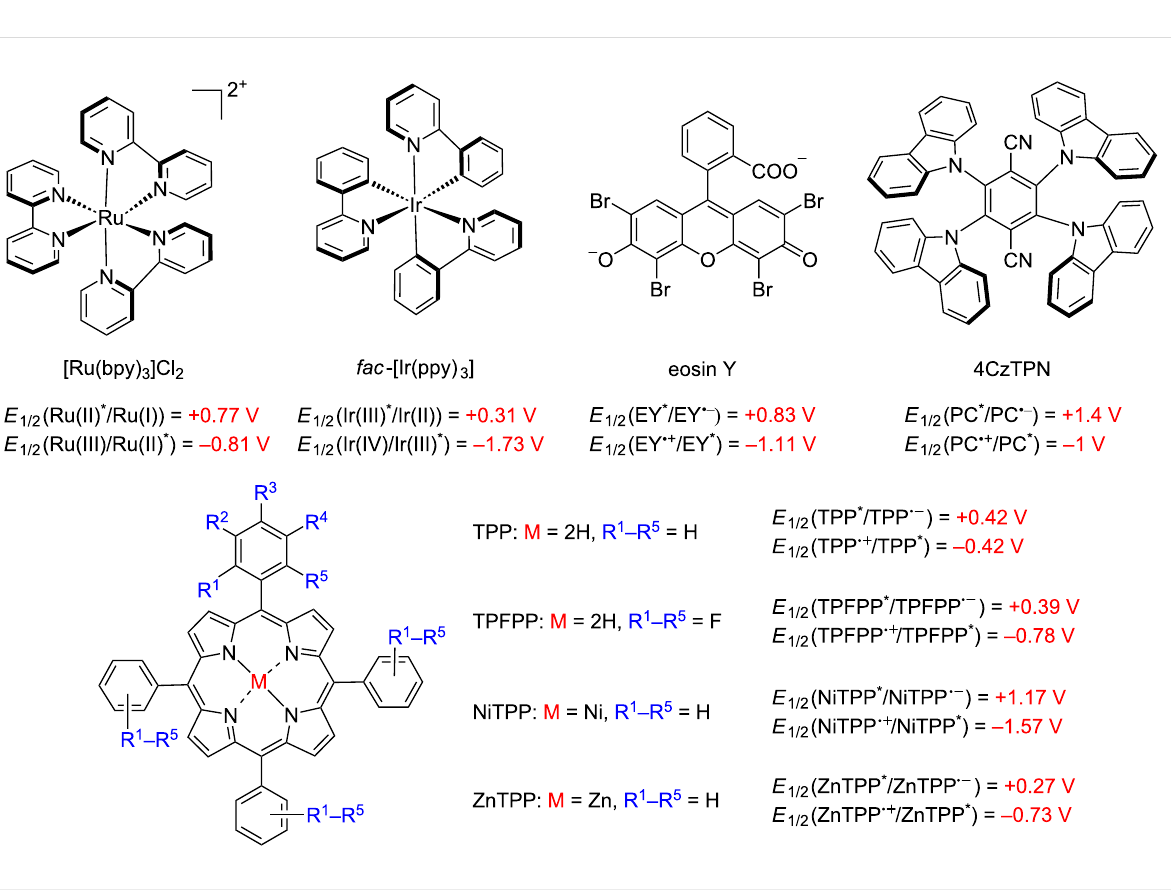
Figure 3: Main dual photocatalysts and their oxidative/reductive excited state potentials, including porphyrin derivatives. Adapted from [10,12,22].